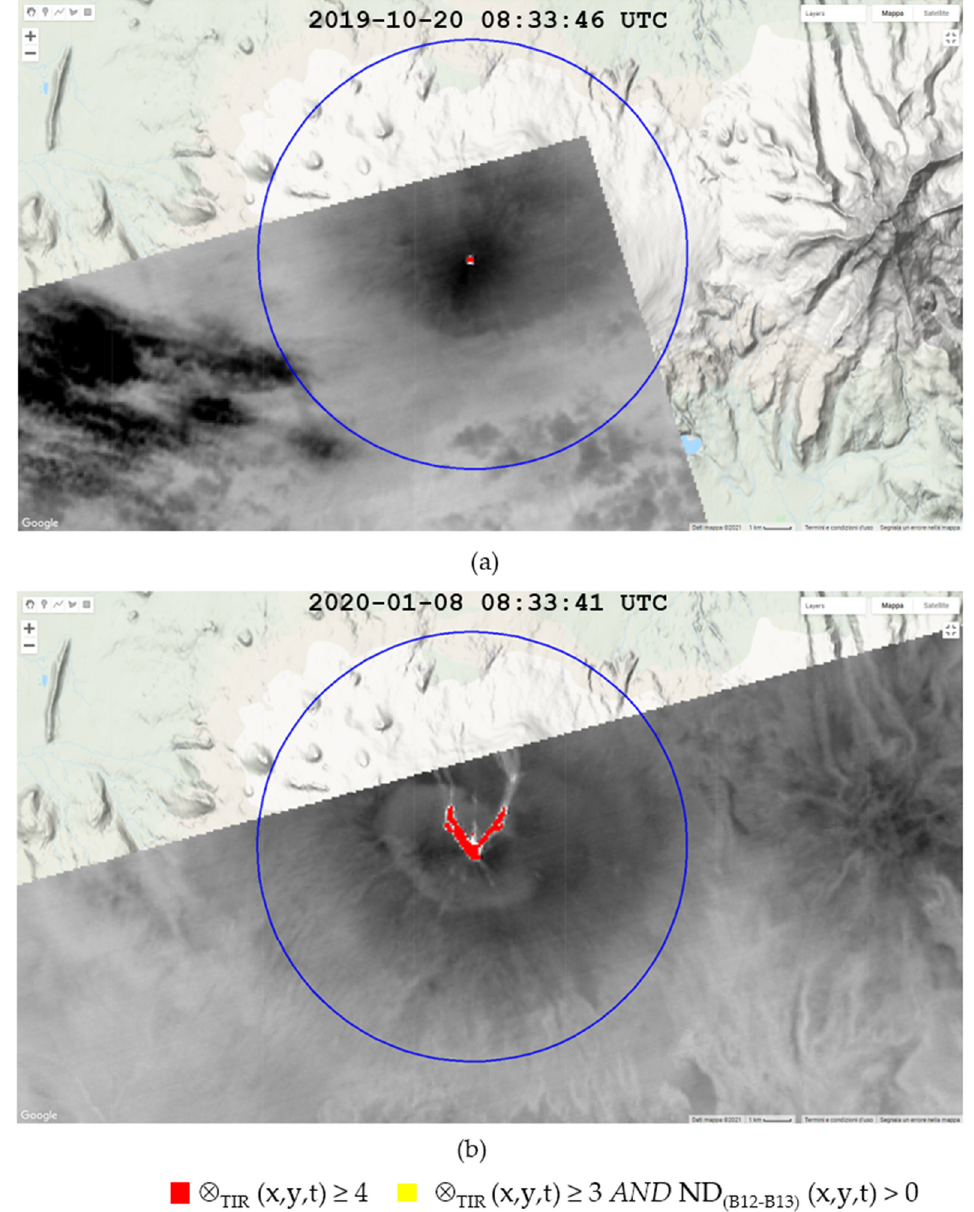
Figure 6. Thermal anomalies detected by RASTer at Shishaldin volcano on ASTER scenes of 20 October 2019 ( a ) and 8 January 2020 ( b